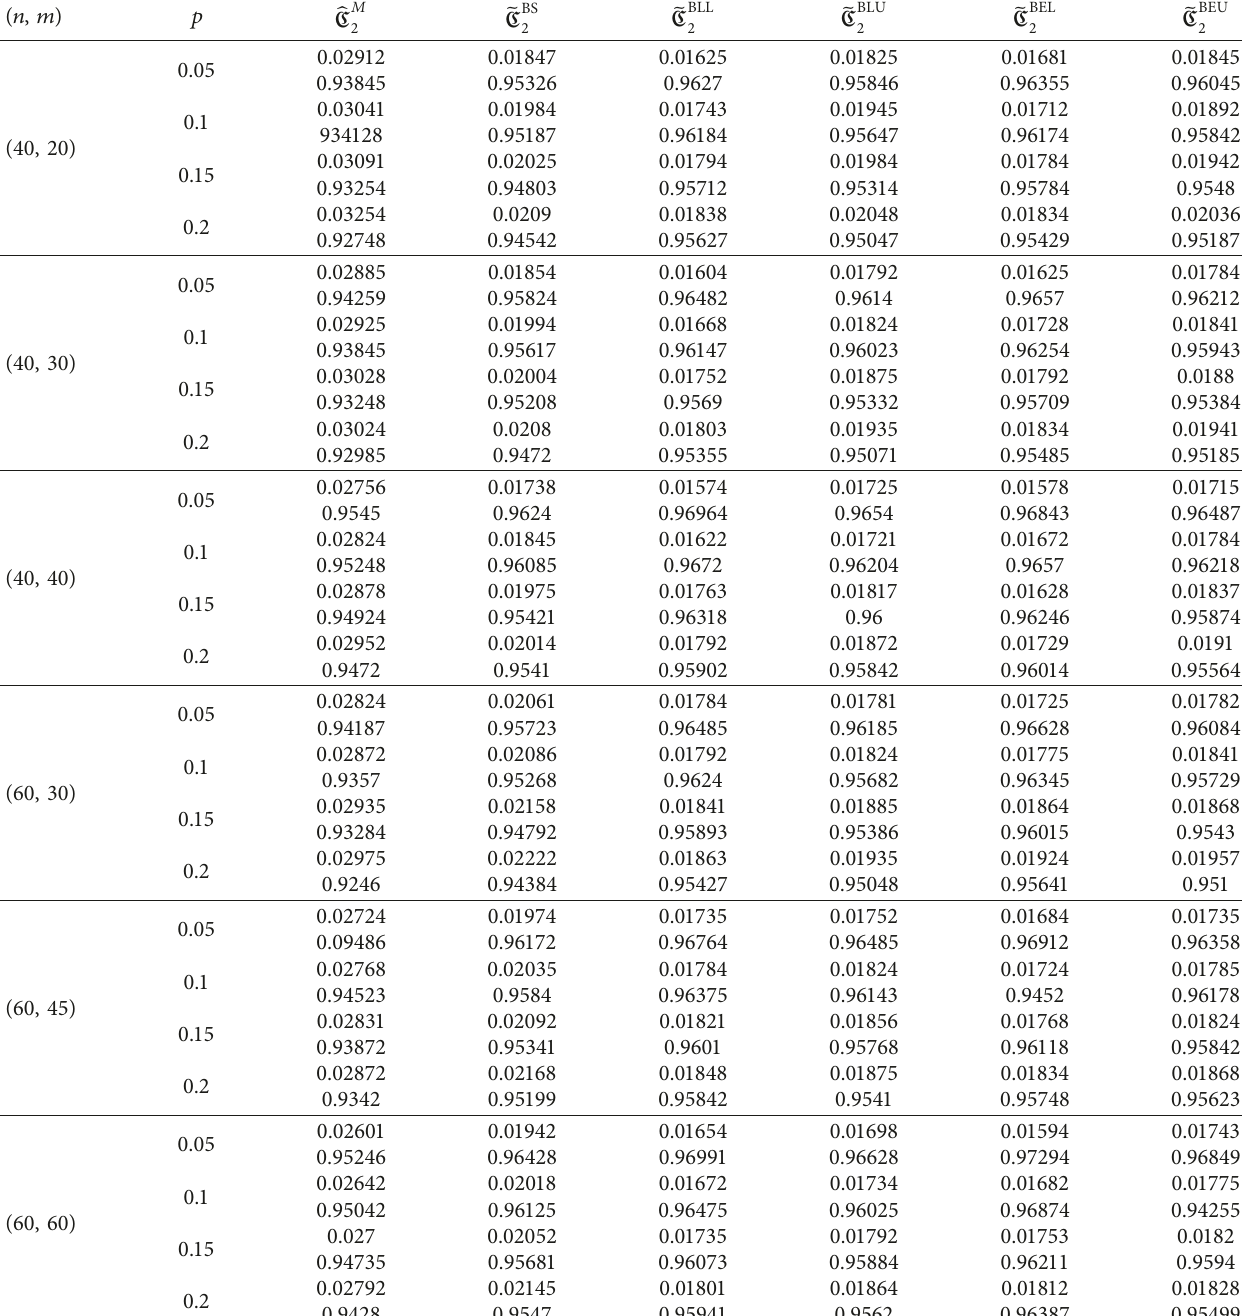
Table 12: Confidence interval of cumulative incidence function for first component C and p